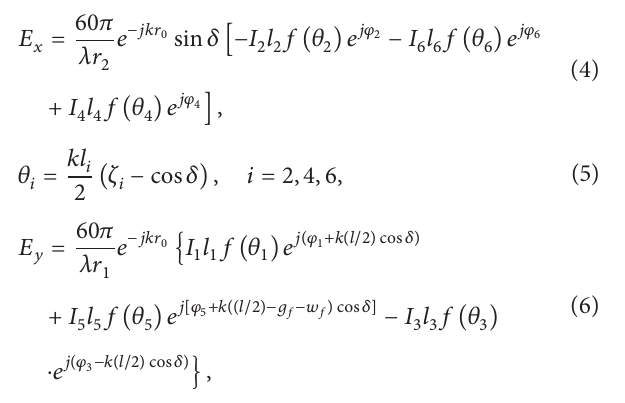
on 𝑦𝑜𝑧 -plane and (10) ∼ (11) express the field component of 𝑦 direction on 𝑦𝑜𝑧